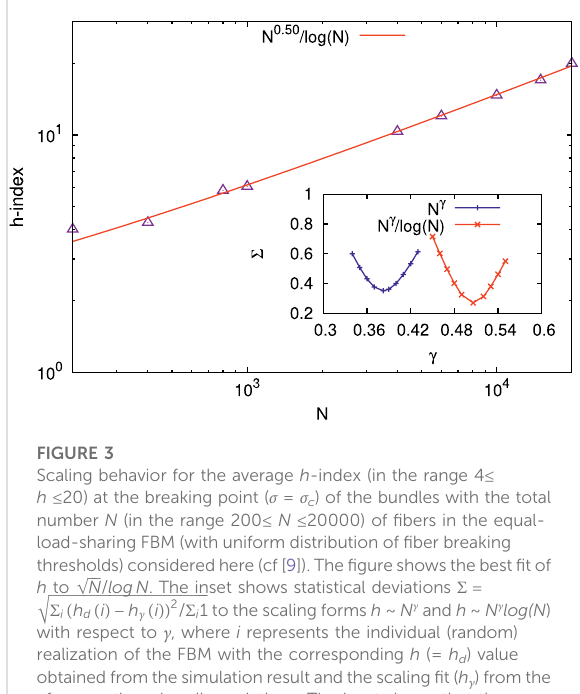
FIGURE 3 Scaling behavior for the average h -index (in the range 4 ≤ h ≤ 20) at the breaking point ( σ = σ c ) of the bundles with the total number N (in the range 200 ≤ N ≤ 20000) of fi bers in the equal- load-sharing FBM (with uniform distribution of fi ber breaking thresholds)consideredhere(cf[9]).The fi gureshowsthebest fi tof (cid:1)(cid:1) √ h to N / logN . The inset shows statistical deviations Σ (cid:3) (cid:1)(cid:1)(cid:1)(cid:1)(cid:1)(cid:1)(cid:1)(cid:1)(cid:1)(cid:1)(cid:1)(cid:1)(cid:1)(cid:1)(cid:1)(cid:1)(cid:1)(cid:1)(cid:1) Σ